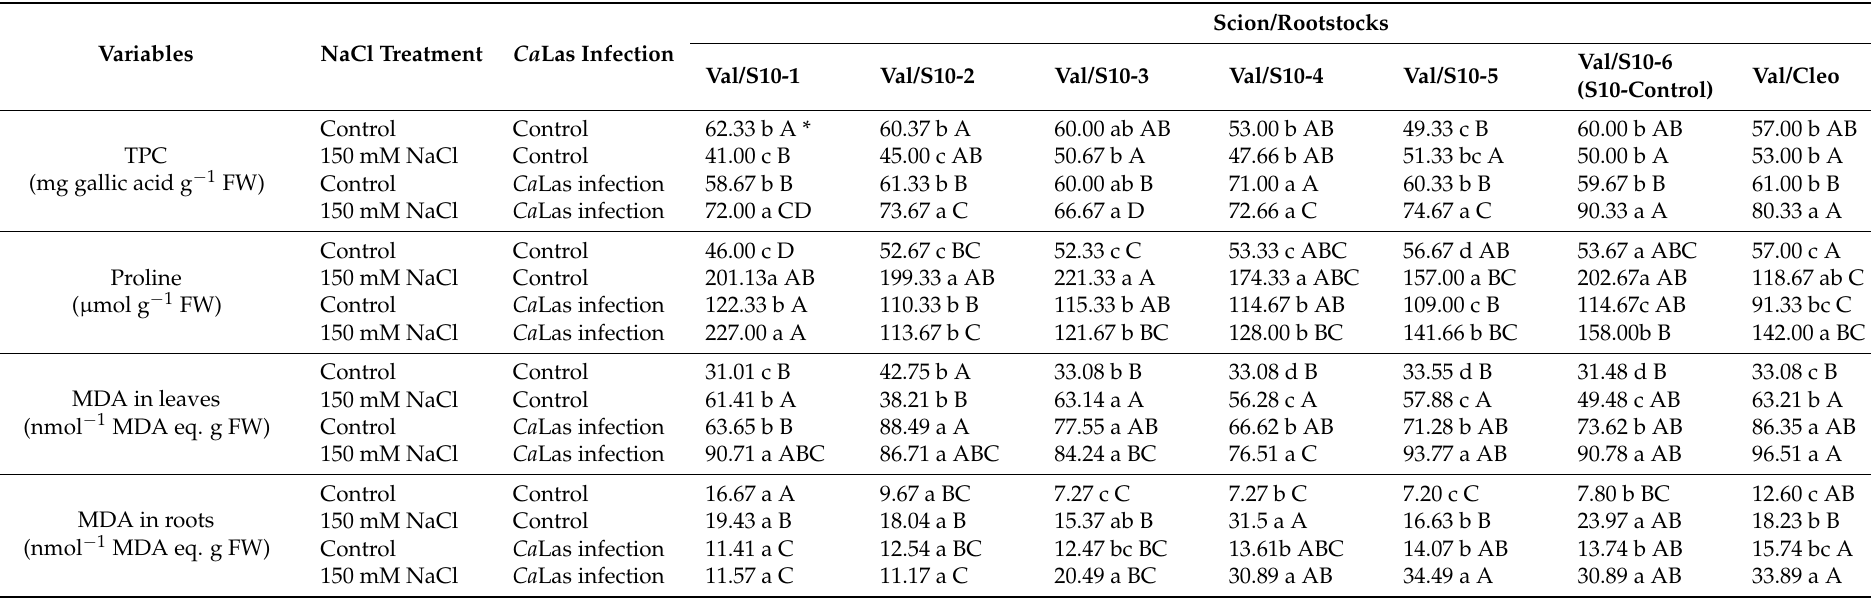
Table 3. NaCl treatment and Ca Las infection on TPC, proline, MDA content of ‘Valencia’ sweet orange scions grafted onto S10-derived rootstocks and Cleopatra mandarin